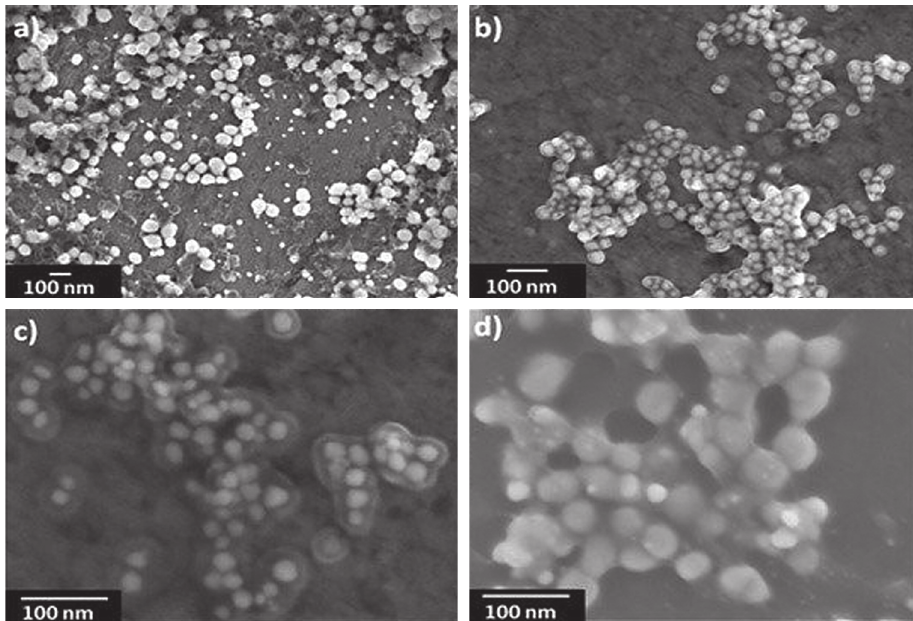
Figure 4: SEM images at different magnifications: (a) 50,000x, (b) 100,000x, (c) 200,000x, and (d) 220,000x [89] (open access and reprinted under CC BY 4.0). Table 1: Morphology of Ag NPs and their antibacterial